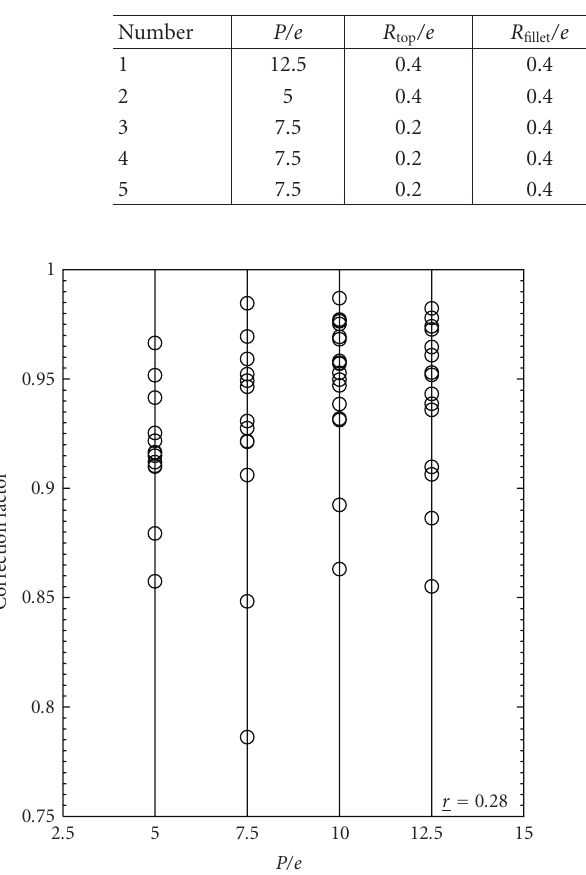
Figure 8: Correction factor variation with P/e for the set of chosen data.